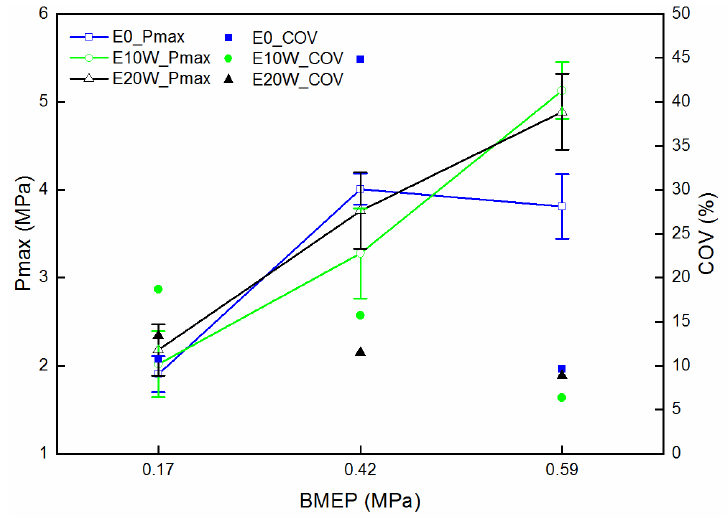
Figure 8. The cycle-by-cycle variations in Pmax for E0, E10W and E20W under three various loads.